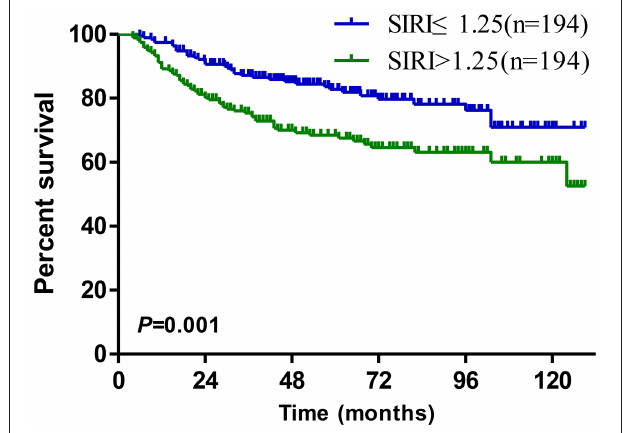
Frontiers in Oncology |